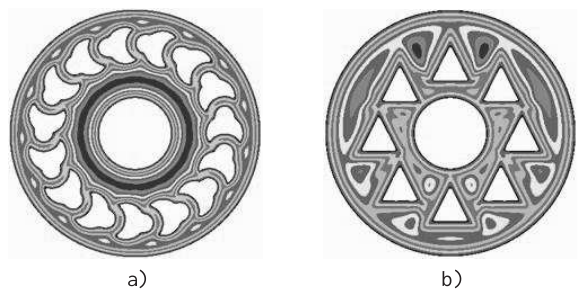
Figure 5. Contour lines: a) function (3.8) for r 0 = 5 , r 01 = 1 , r 02 = 0 . 5 , r 03 = 1 , k 1 = 1 , k 2 = − 1 , m = 15 , b) function (3.9)